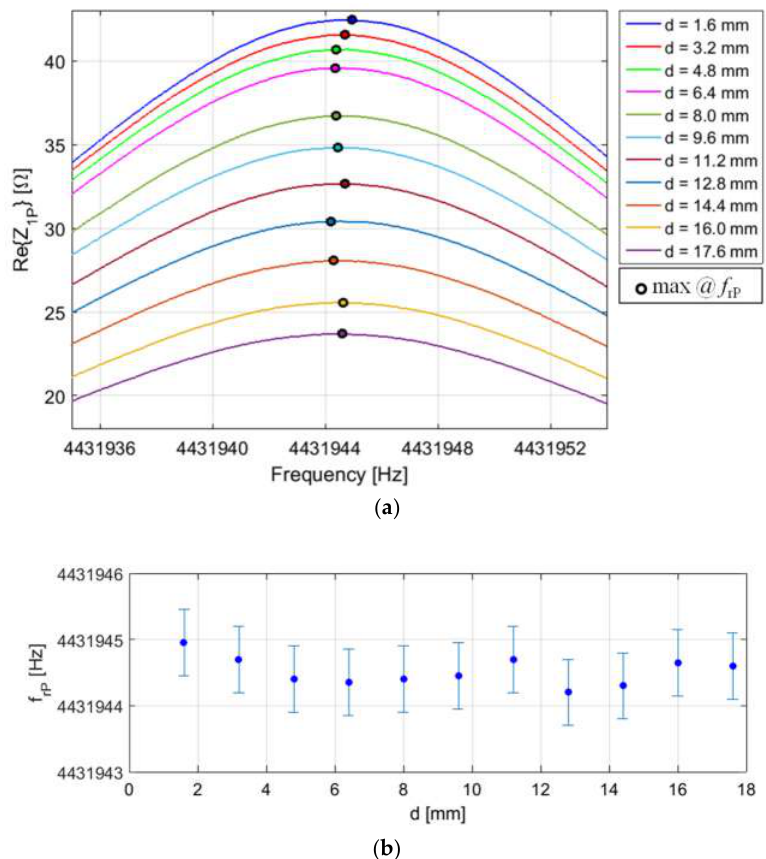
Figure 20. ( a ) Real part of Z 1P measured around the mechanical resonant frequency f r of the quartz crystal resonator (QCR) connected to the primary coil CL 1 for different distances d . The frequency of the maxima at f rP is highlighted with a black circle. ( b ) Frequency f rP as a function of d . The error bars report the standard deviations calculated over 5 repeated measurements.